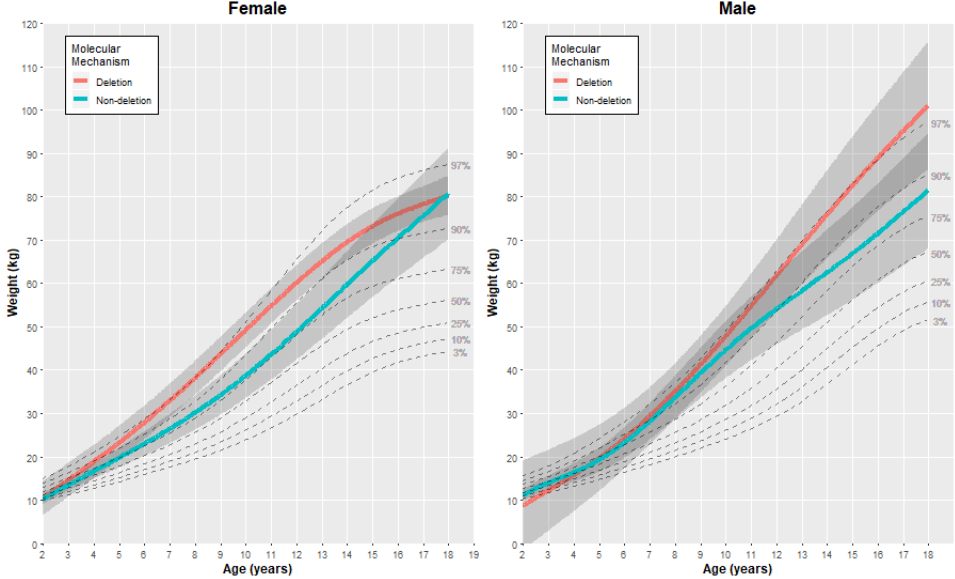
Figure 3. Estimated growth curves for the weight of individuals with the deletion or non-deletion mechanism causing PWS in our study cohort (colored lines), alongside the normative percentile ranges of weight growth (dashed gray lines).